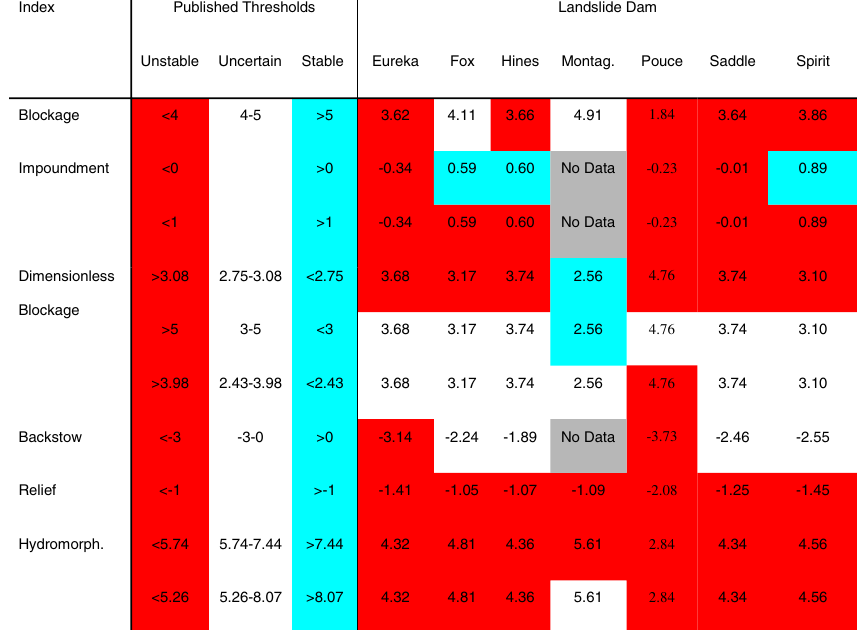
Table 5 Results of the assessment of landslide dam stability indices